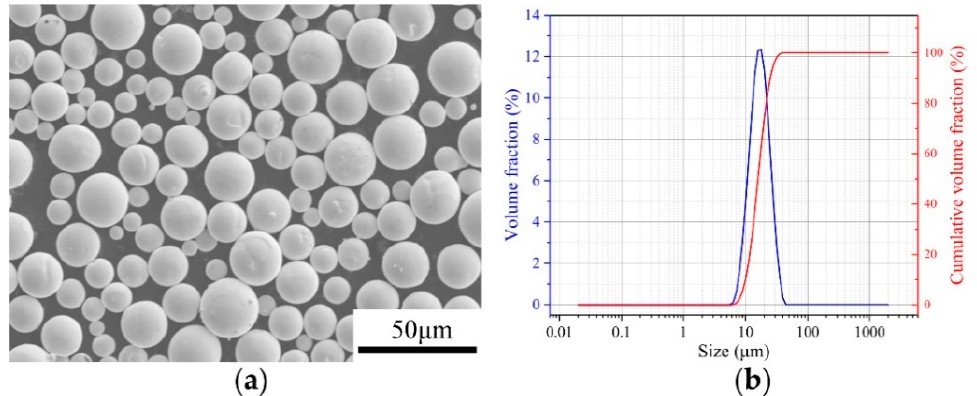
Figure 1. ( a ) SEM morphology of tungsten powder; ( b ) particle size distribution.